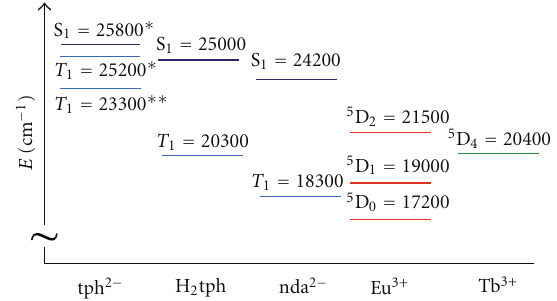
Figure 5: Simplified energy diagram of Eu 3+ , Tb 3+ , nda 2 − , and H 2 tph, and tph 2 − ( ∗ tph 2 − energy levels values were taken from [20]; ∗∗ tph 2 − energy levels values were taken from